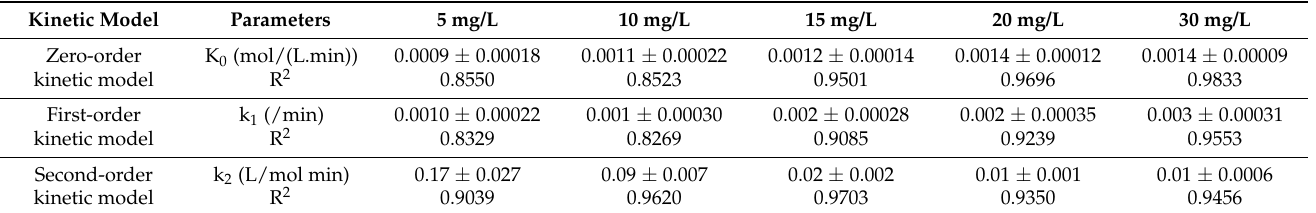
Table 3. The zero ‐ , first ‐ , and second ‐ order kinetic parameters using 10 mg/L MB for photodegra ‐ dation of MB of different concentrations.